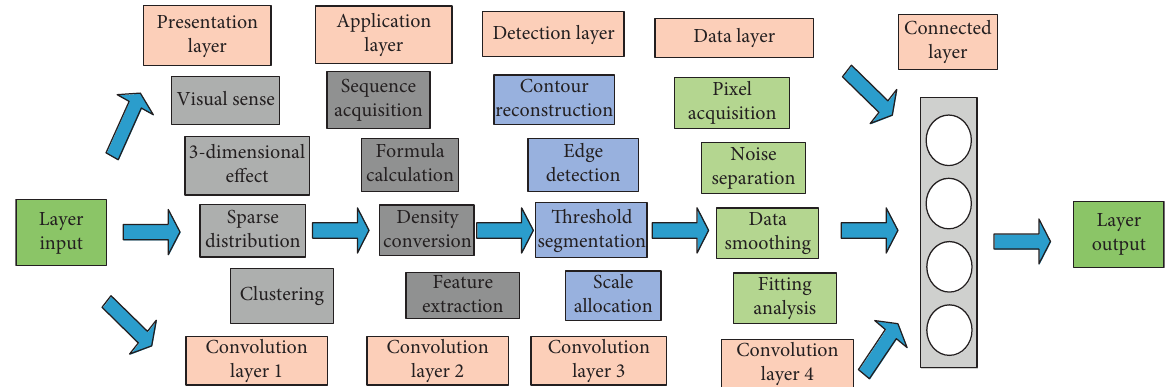
Figure 1: Flowchart of characteristic layers of image sculpture